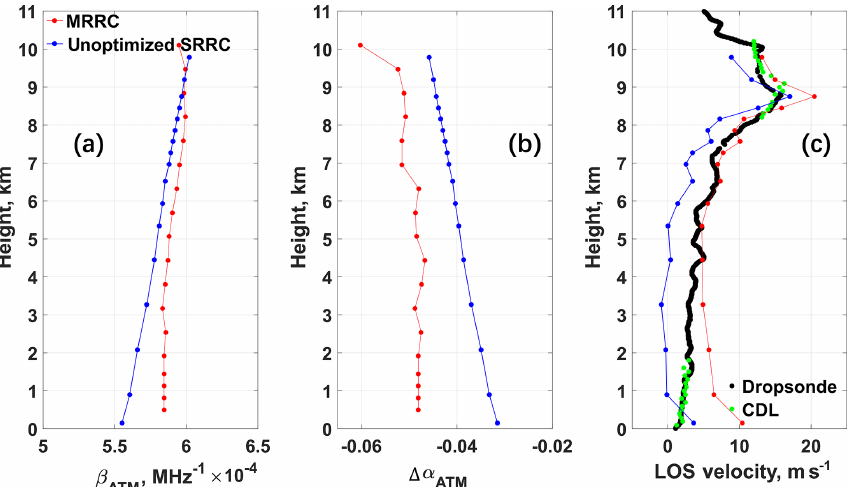
Figure 7. Case study using dropsonde data on 08:27:07UTC, 23 September 2016: comparison of (a) sensitivity β ATM (MHz − 1 ), (b) (cid:49)α ATM , and (c) LOS velocity between results from A2D Rayleigh channel MRRC (red) and not optimized SRRC (blue). The LOS velocity data from dropsonde (black) and CDL (green) are also presented in Fig.